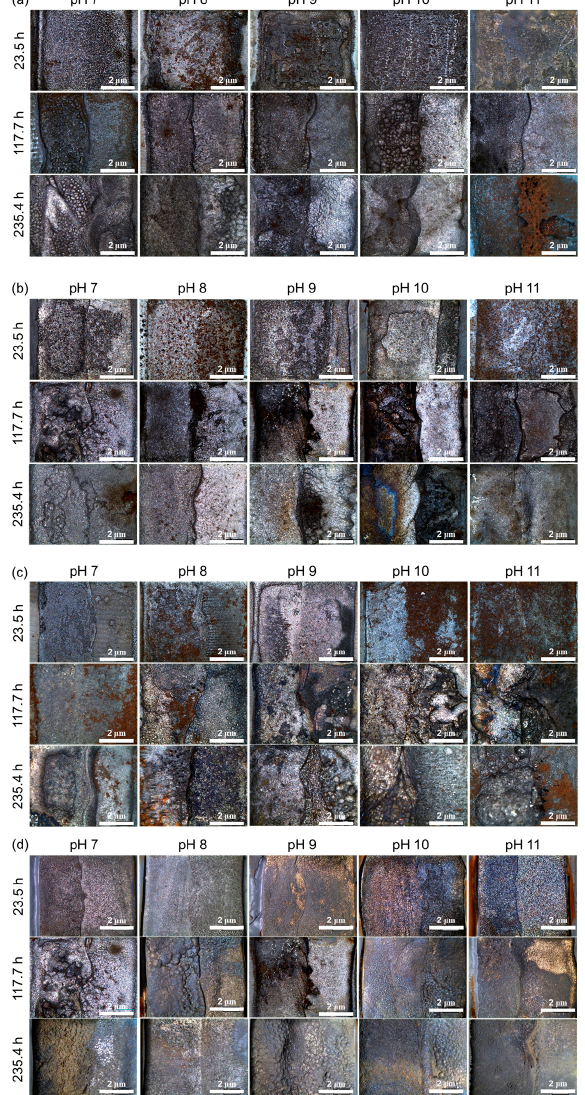
Figure 5. Photographs of weldment after the corrosion acceleration. DO: ( a ) 0, ( b ) 200, ( c ) 1000, and ( d ) 8000 ppb.